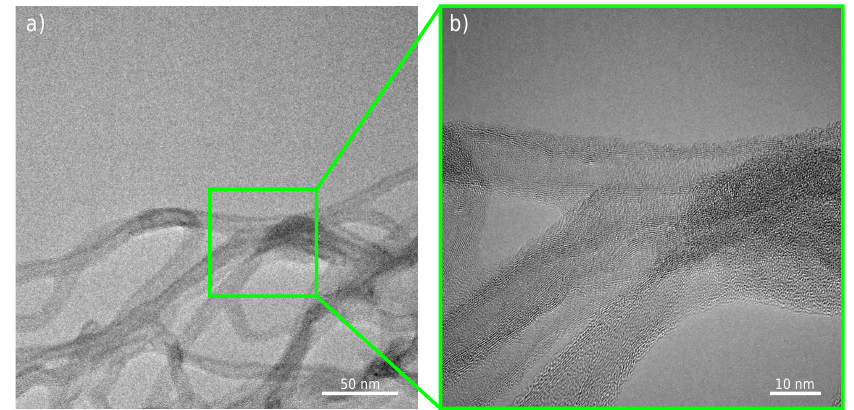
Figure A14. TEM images for CNTA at ( a ) low magnification and ( b ) high magnification.